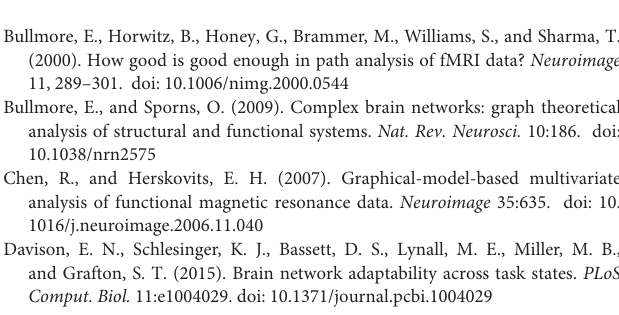
TABLE S1 | Regions of interests chosen from other references on MDD. TABLE S2 | Comparison among Similar Researches. TABLE S3 | Probability to identify as a patient of all subjects. TABLE S4 | Classification performance of the three methods about AD dataset. TEXT S1 | Image